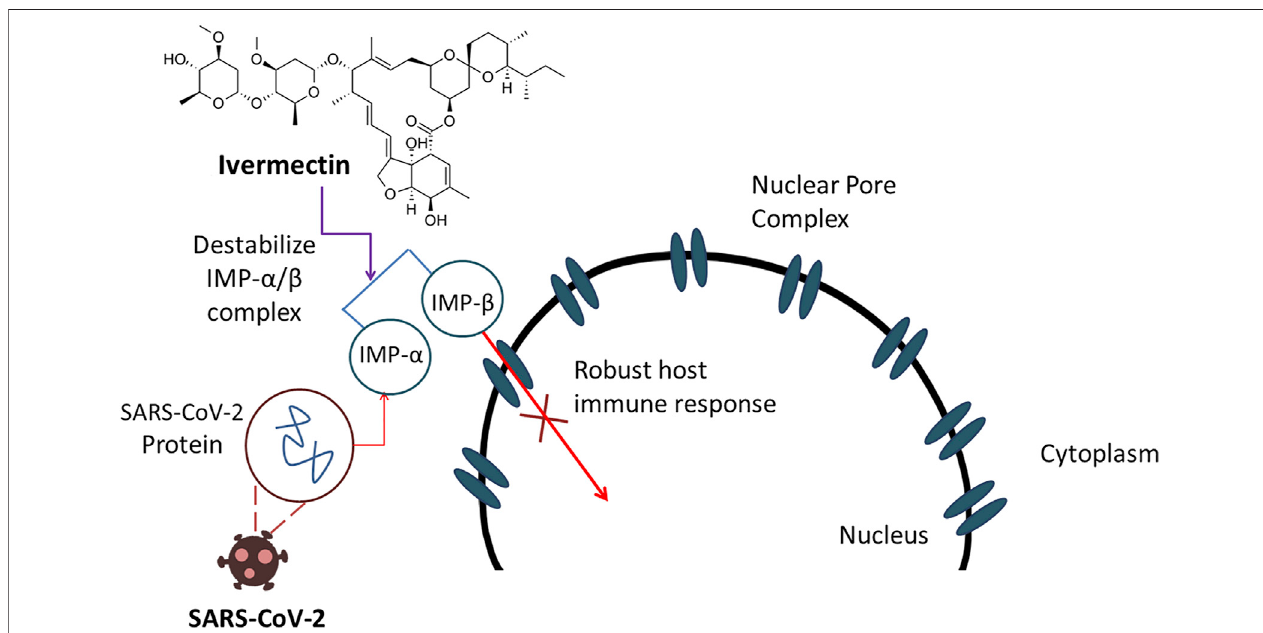
FIGURE5| Ivermectindemonstratesanti-COVID-19actionbyinhibitingnucleartransportresultedbydestabilizationofIMP- α / β complexwhichultimatelydamages RNA viruses.